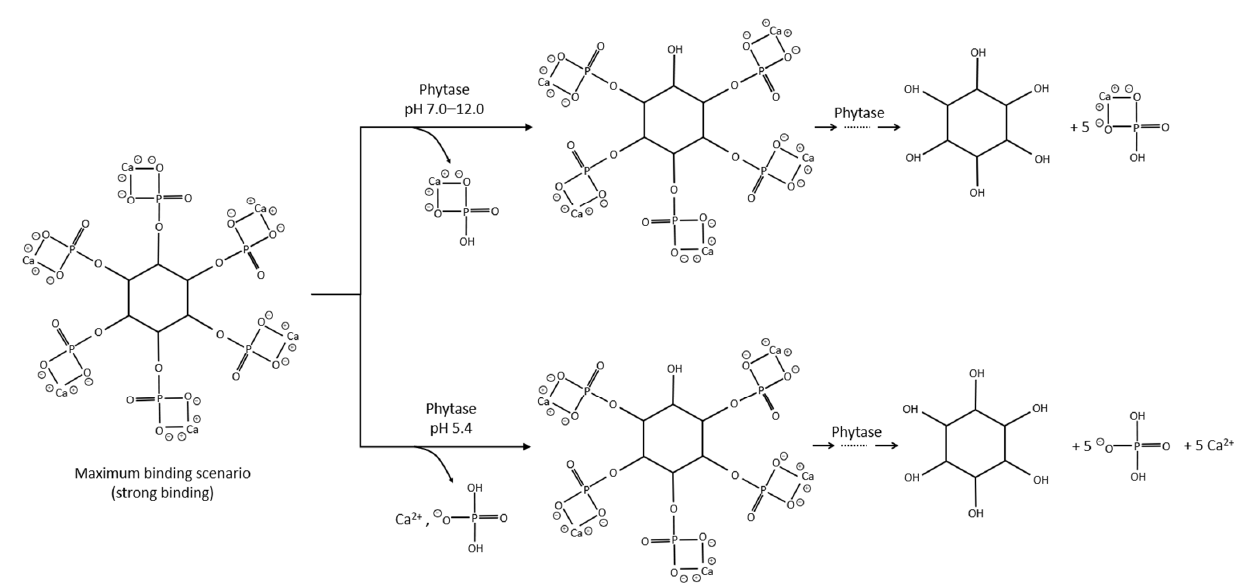
Figure 10. Schematic representation of the hypothetical reaction between calcium phytate and phytase